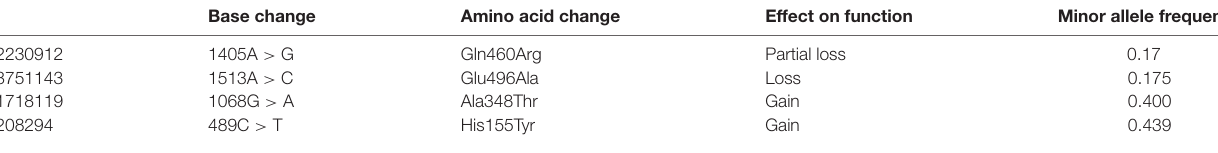
TABLE 1 | Principal published characteristics of P2RX7 SNP